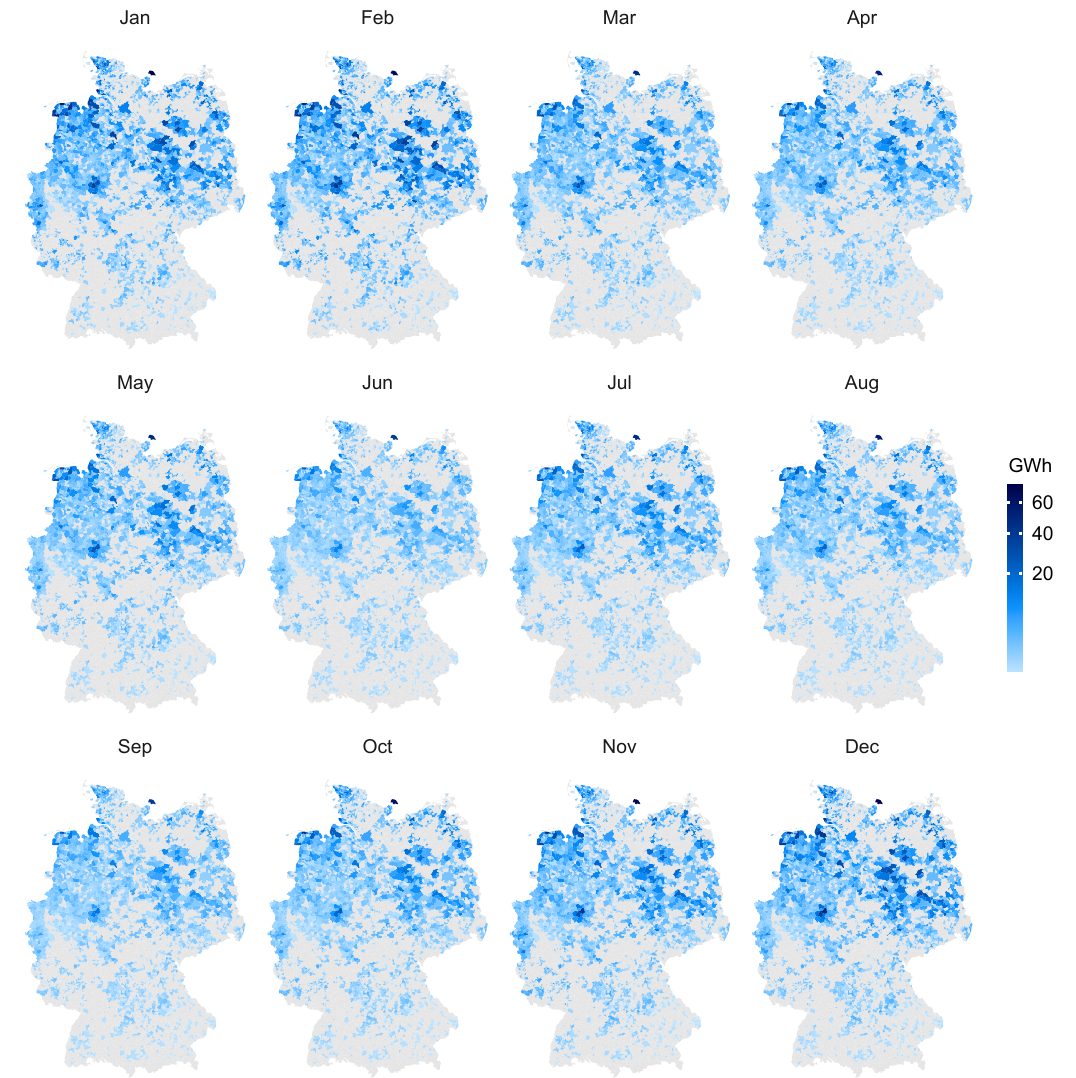
Figure 10. Aggregated monthly electricity production from onshore turbines at LAU2 level in Germany for 2016. In the grey areas no wind turbines are installed.